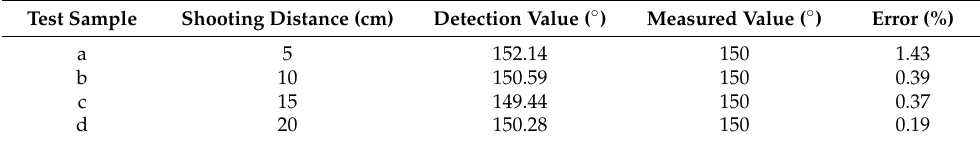
Figure 9. Identification results of bolt loosening under different shooting distances: ( a ) 5 cm; ( b ) 10 cm; ( c ) 15 cm; ( d ) 20 cm. Table 5. Experimental data analysis of bolt loosening under different shooting distances.